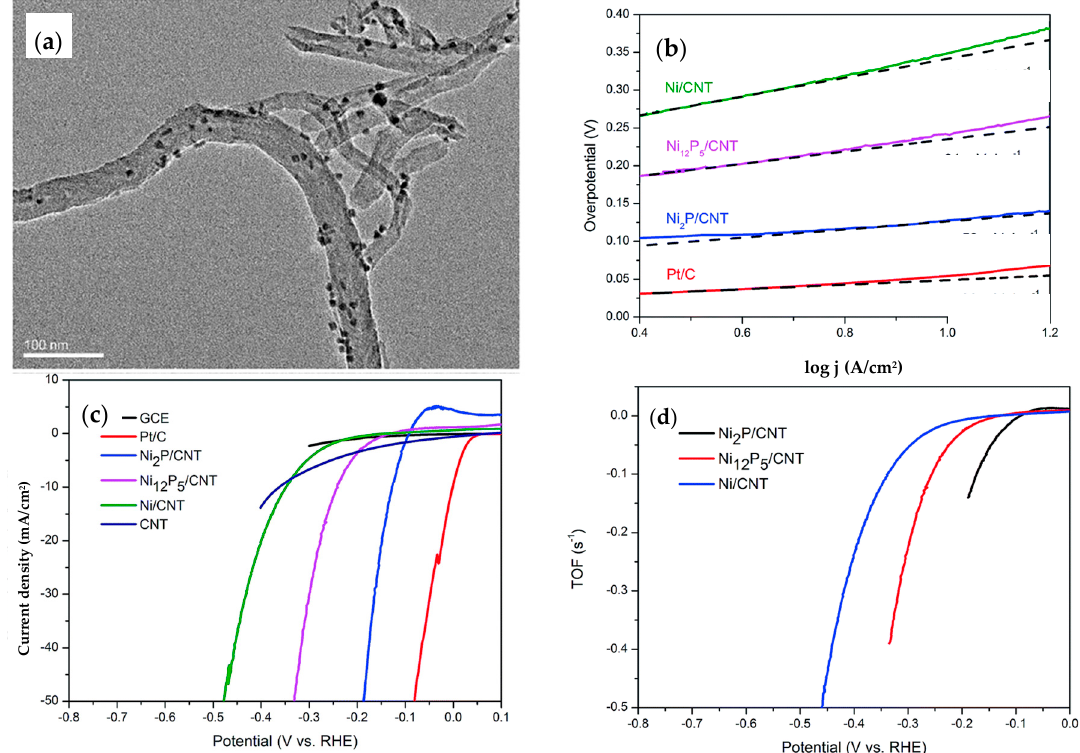
Figure 9. ( a ) TEM image of Ni 2 P/CNT. ( b ) Tafel plots of the Ni 2 P/CNT, Ni 12 P 5 /CNT, Ni/CNT and Pt/C. ( c ) LSV curves of the Ni 2 P/CNT, Ni 12 P 5 /CNT, Ni/CNT, Pt/C, CNT and bare GCE in 0.5 M H 2 SO 4 with a scan rate of 5 mV/s. ( d ) Calculated TOFs for the Ni 2 P/CNT, Ni 12 P 5 /CNT and Ni/CNT in 0.5 M H 2 SO 4 . Reprinted with permission from [136]. Copyright 2017 The Royal Society of Chemistry.